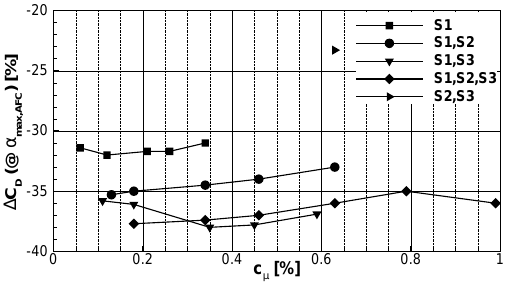
Figure 19. Drag reduction at α max , AFC for different momentum coefficients and segment combinations.